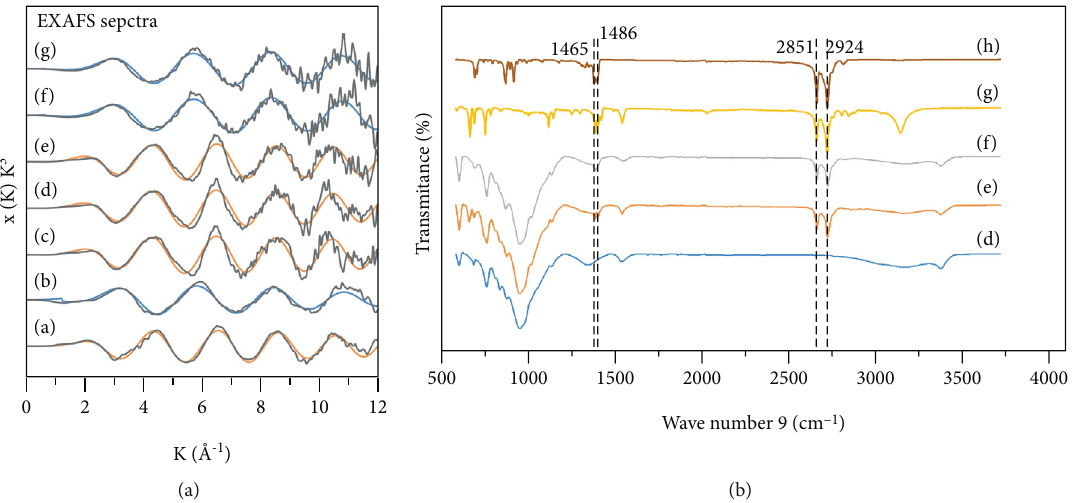
Figure 6: (a) – (c) X-ray di ff ractograms of NTB, 1CPC, and 1HDTMA, respectively. (d) – (h) FTIR spectra of NTB, 1CPC, 1HDTMA, CPC, and HDTMA,